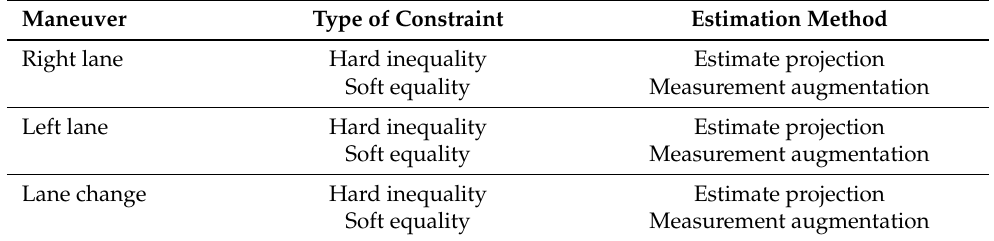
Table 5. Constraint type of lateral